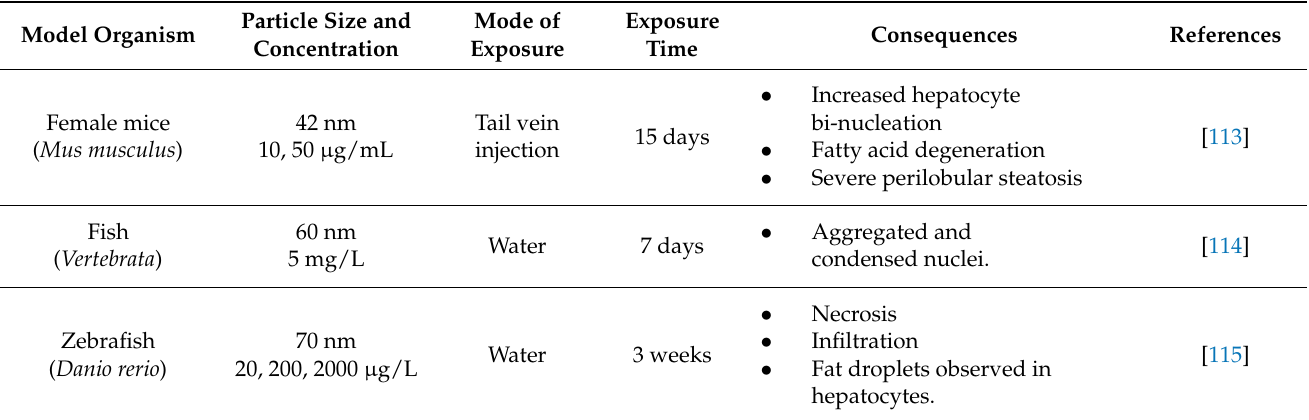
Table 1. The effects of accumulation of NPs in the liver of various model